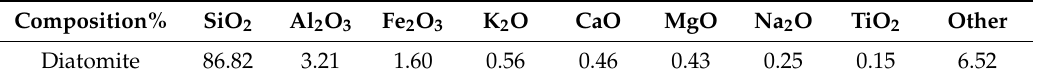
Table 1. Chemical analyses of diatomite